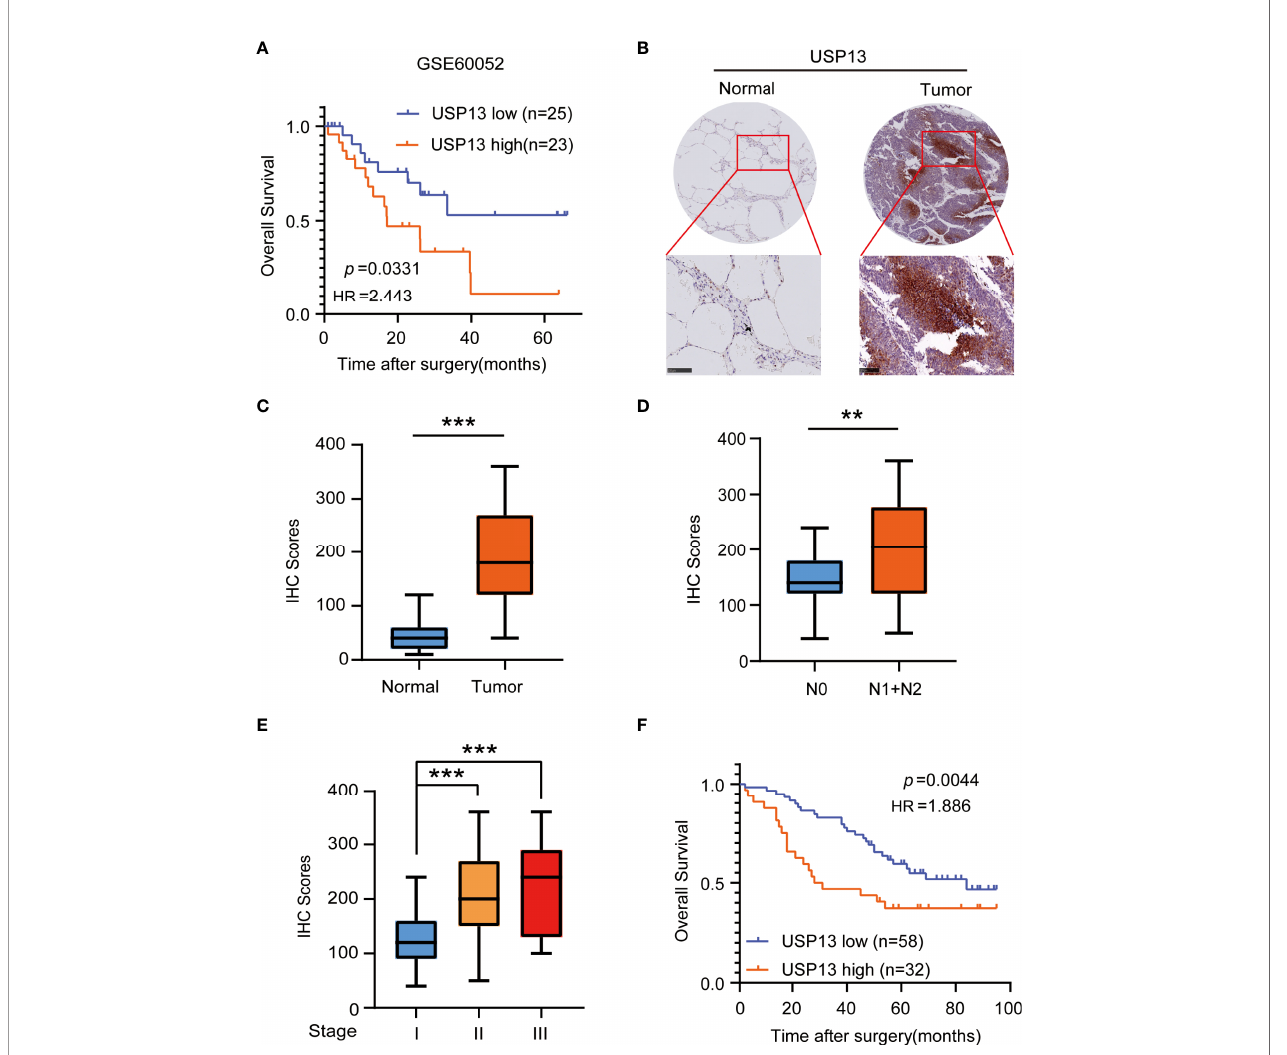
FIGURE 1 | USP13 is overexpressed in SCLC and predicts poor clinical outcomes. (A) Kaplan-Meier analysis of overall survival curves from a public dataset (GSE60052) for SCLC patients with low or high USP13 expression. p values are calculated using a log-rank test (two-tailed). (B, C) Immunohistochemical analysis of USP13 in SCLC tumor specimens (T) and their adjacent normal tissues (N). Representative IHC images are shown ( B ). IHC scores of USP13 expression were calculated ( C ). Scale bars: 500 µm. Data represent the means ± SD of samples. Two-tailed student ’ s t-test was used. *** p < 0.001. (D) The expression of USP13 in SCLC patients with or without lymph node metastasis is shown. Data represent the means ± SD of samples. Two-tailed student ’ s t-test was used. ** p < 0.01. (E) USP13 expression levels are shown in SCLC patients of different cancer stages. Data represent the means ± SD of samples. Two-tailed student ’ s t-test was used. *** p < 0.001. (F) The Kaplan – Meier method with a two-tailed log- rank test was used to plot survival curves for SCLC patients with high and low USP13